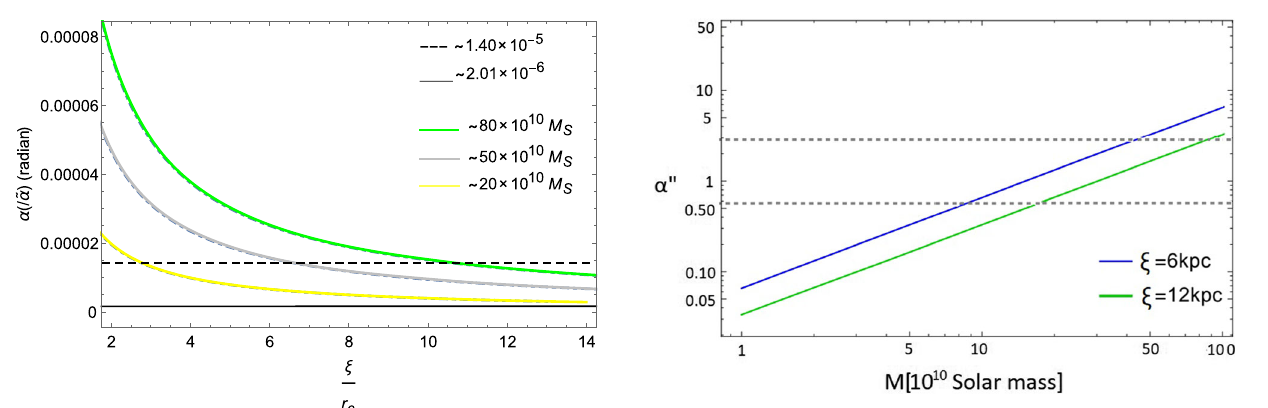
Fig. 5 The variation of the light deflection angles (Eqs. (39) and (40)) as a function of the scaled impact parameter has been plotted together with the data from [91] with δ ≈ O ( 10 − 6 ) . The dashed and solid horizontal lines correspond to the minimum and maximum values of the deflection angles observed for the considered data sample of typical massive galaxies [91]. The plots that a galaxy with larger mass has a bigger deflection angle. For smaller value of δ , the f ( R ) contribution is more concentrated in the vicinity of baryonic mass with ξ/ r c < 1, and thus we have a decreasing profile of deflection angle in the galactic halo of scalaron cloud background with ξ/ r c > 1